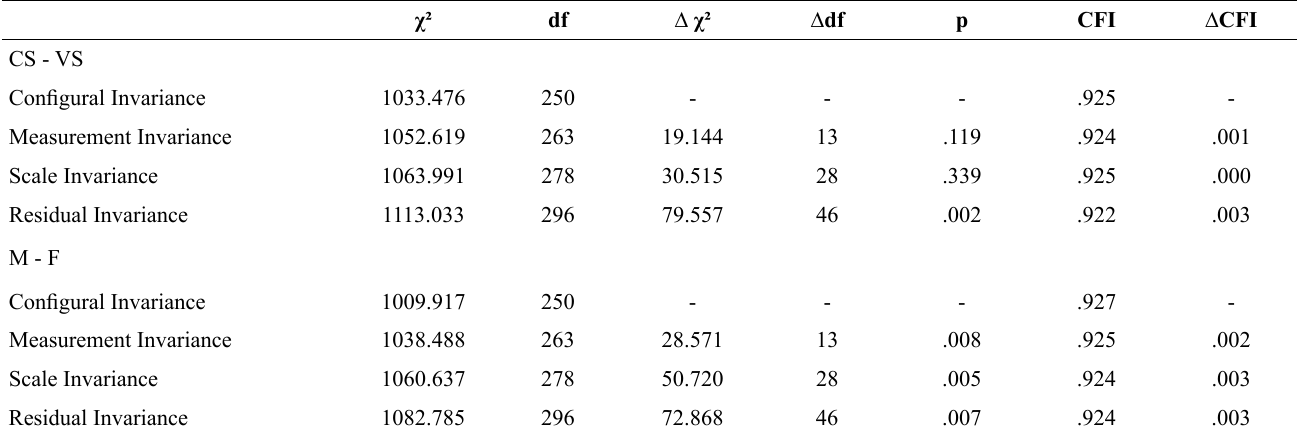
Table 4 Fit indices for the invariance of the measurement model of the PLOCQ in the Portuguese sample across χ²